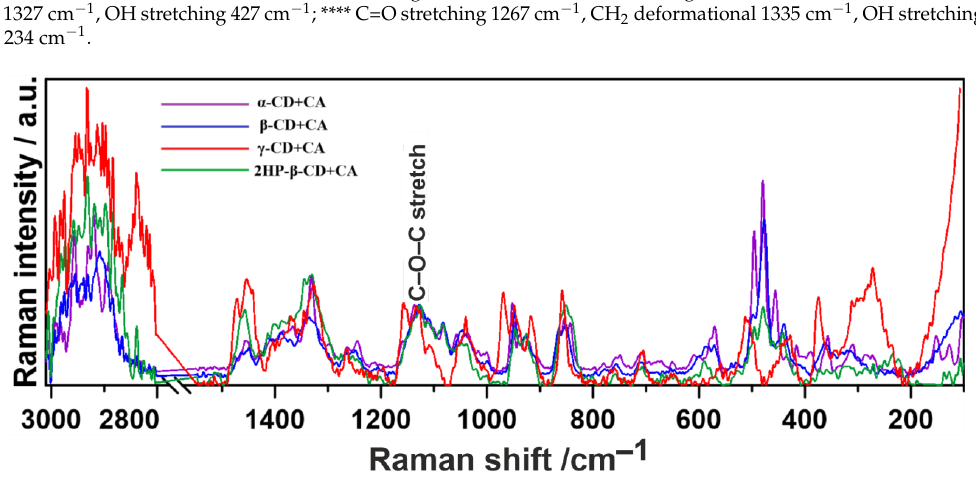
Figure 6. Raman spectra normalized to 1127 cm −1 (α-CD+CA and β-CD+CA), 1133 cm −1 (γ-CD+CA) and 1126 cm −1 (2HP-β-CD+CA) bands. Table 3. The comparison of Raman intensity ratios for specific chemical groups. The calculated results are demonstrated as mean ± standard deviation (SD).